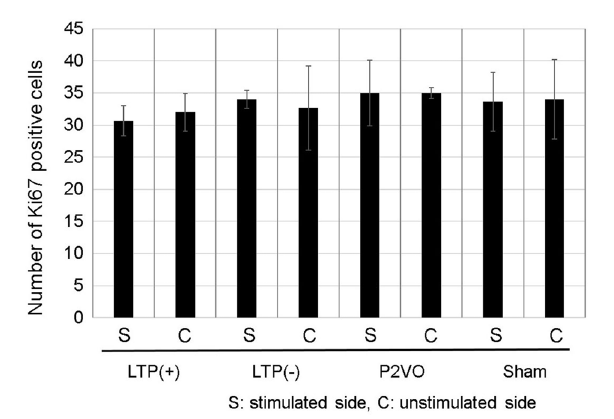
FIGURE 6 | Compared with the sham group, the hypoperfusion effect could not enhance neurogenesis in the DG in the chronic phase following P2VO. Although LTP induction in the subacute phase after P2VO effectively enhanced neurogenesis in the DG, LTP induction in the chronic phase following P2VO could not enhance neurogenesis (each group N =